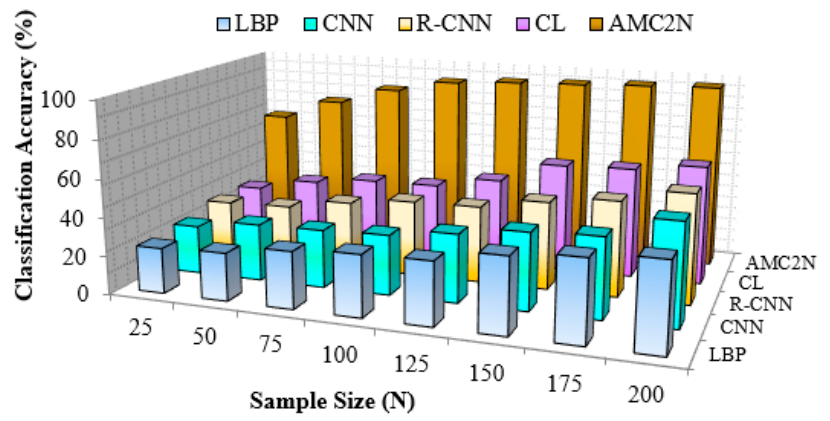
Figure 11. Comparison of classification accuracy (Scenario 2).